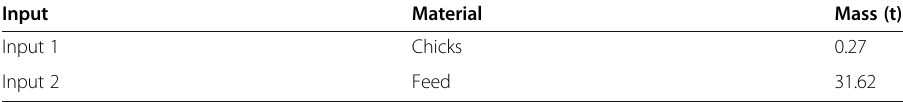
Table 1 Materials and related